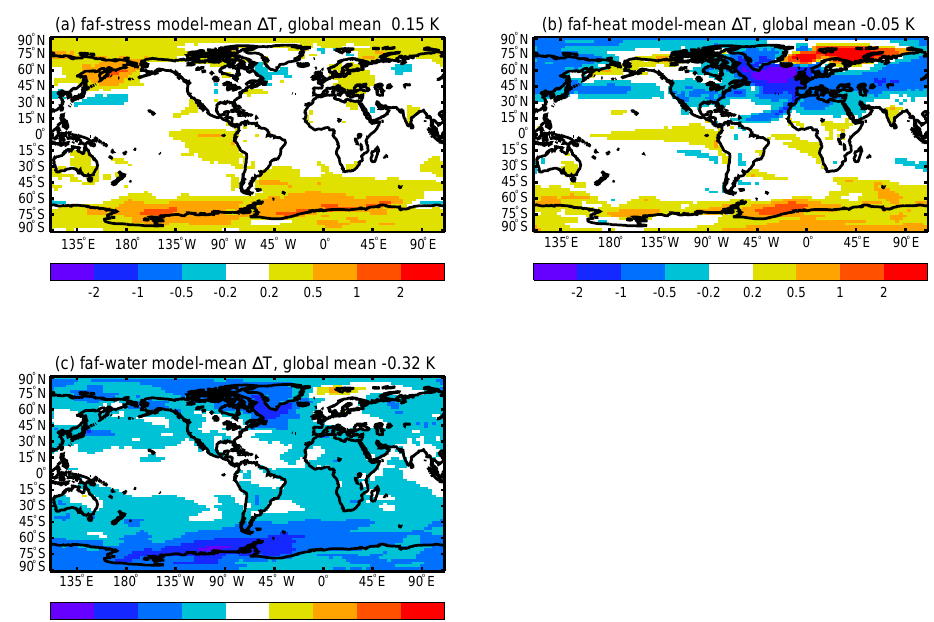
Figure 6. Change in surface air temperature (K) in the time mean of the final decade of the FAFMIP experiments relative to the control. Note that T R , not θ , is used to supply SST to the atmosphere model in faf-heat, so the change in θ due to the added heat does not affect the surface air temperature (Sect. 2.4, Fig.